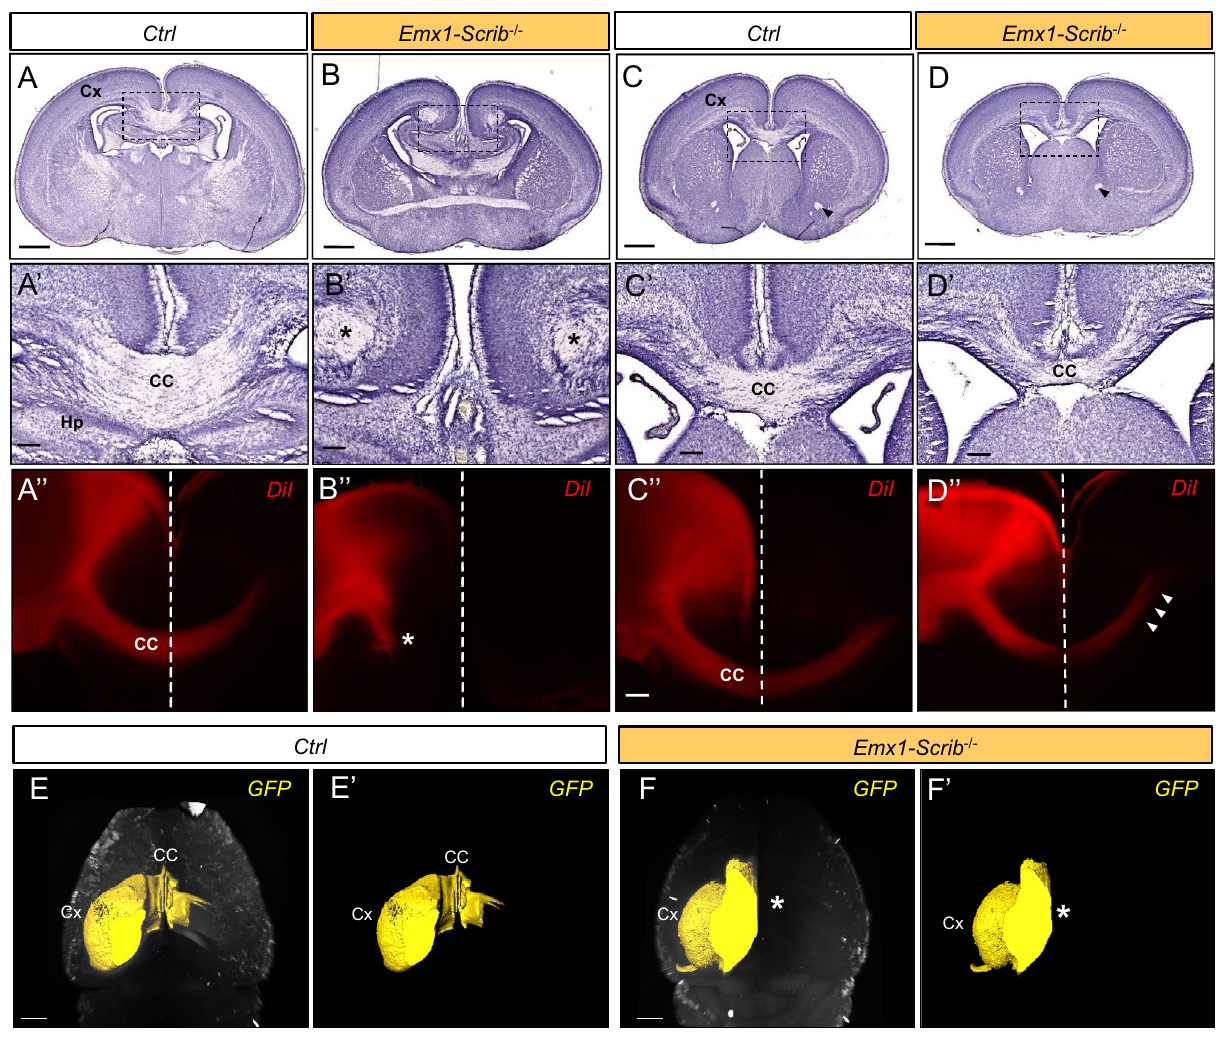
Figure 5. Partial corpus callosum agenesis in Emx1-Scrib −/− cKO mutants. ( A – D ) Representative hematoxylin staining of coronal sections from newborn Emx1-Scrib −/− cKO brains ( B , D ) and their respective controls ( A , C ) at the caudal ( A , B ) or rostral ( C , D ) levels. Dashed boxes in ( A , D ) are magnified in ( A ′ – D ′ ). ( A ′ –D ′ ) Higher magnification for selected insets (boxed areas) from ( A – D ) illustrating high penetrance of CC agenesis (ACC) at the caudal level. At P0, 93% of Emx1-Scrib −/− (n = 28) cKO brains displayed ACC. Instead of crossing the midline, CC axons formed whorls (Probst bundles, PB) on either side of the midline that are indicated with an asterisk. Compared with control brains, a gap between hemispheres indicates fusion defects. Despite an apparent thinning, CC fibers do cross the midline at the rostral level. ( A ″ –D ″ ) DiI crystals placed in the dorsomedial cortex trace CC axons in Emx1-Scrib −/− cKO brains ( B ″ , D ″ ) and their respective controls ( A ″ , C ″ ) at the caudal ( A ″ – B ″ ) or rostral ( C ″ – D ″ ) levels at P0. Emx1-Scrib −/− cKO brains displayed occasional stalled fibers in some mutant brains (asterisk in B ″ ). Cx cortex, Hp hippocampus, CC corpus callosum. The midline is indicated as a white dashed line. ( E–F ′ ) 3D imaging of adult brains cleared with uDISCO from Emx1-Scrib −/− cKO brains ( F , F ′ , orange) and their respective controls ( E , E ′ ). 3D reconstruction of the GFP expressed after viral infection in the sensory-motor cortex are represented in yellow. In Emx1-Scrib −/− cKO brains, agenesis of the corpus callosum is confirmed by the absence of cortical fibers passing through the contralateral side (asterisk in F ′ ). See also Supplementary Fig